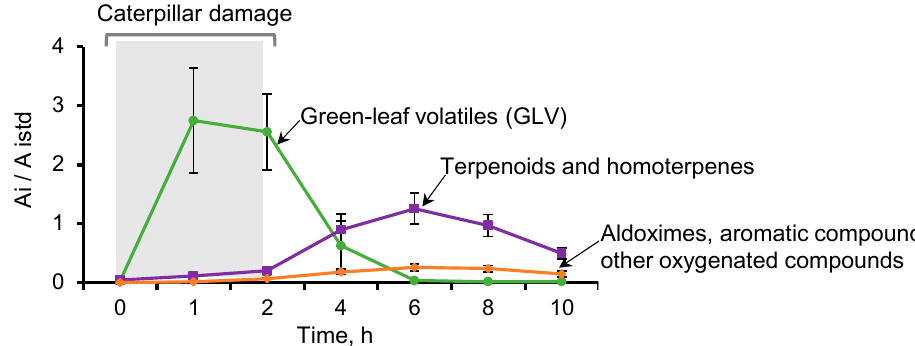
Figure 2. HIPV emission by C . nitens leaves attacked by U . ornatrix caterpillars. The caterpillars were fed for the first two hours, then removed from the plant. Volatiles were extracted using SPME. The ratio between the sum of areas of the group of compounds of interest A i and the area of the internal standard A istd (methyl undecanoate) is reported. Values are the mean ± standard error ( n = 7).